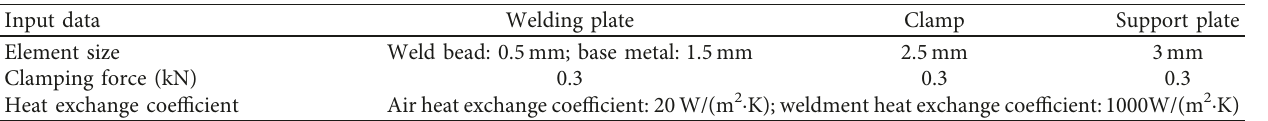
Figure 5: The FEA model: (a) the welding model (from top to bottom: two clamps, the welding plate, and the support plate) and (b) trace points. Table 3: Input data for the FEA